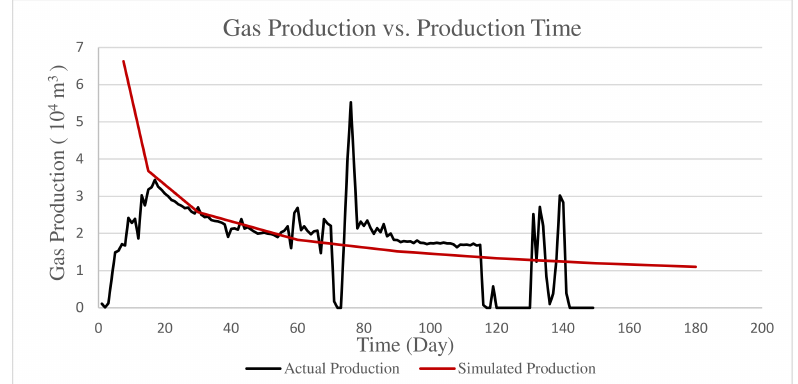
Figure 4. Plot of gas production data with time.